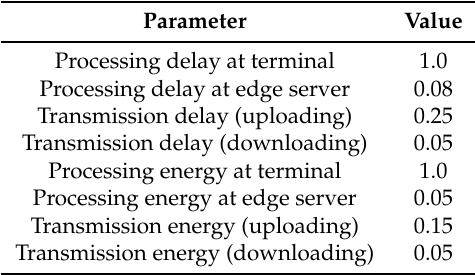
Table 1. Simulation